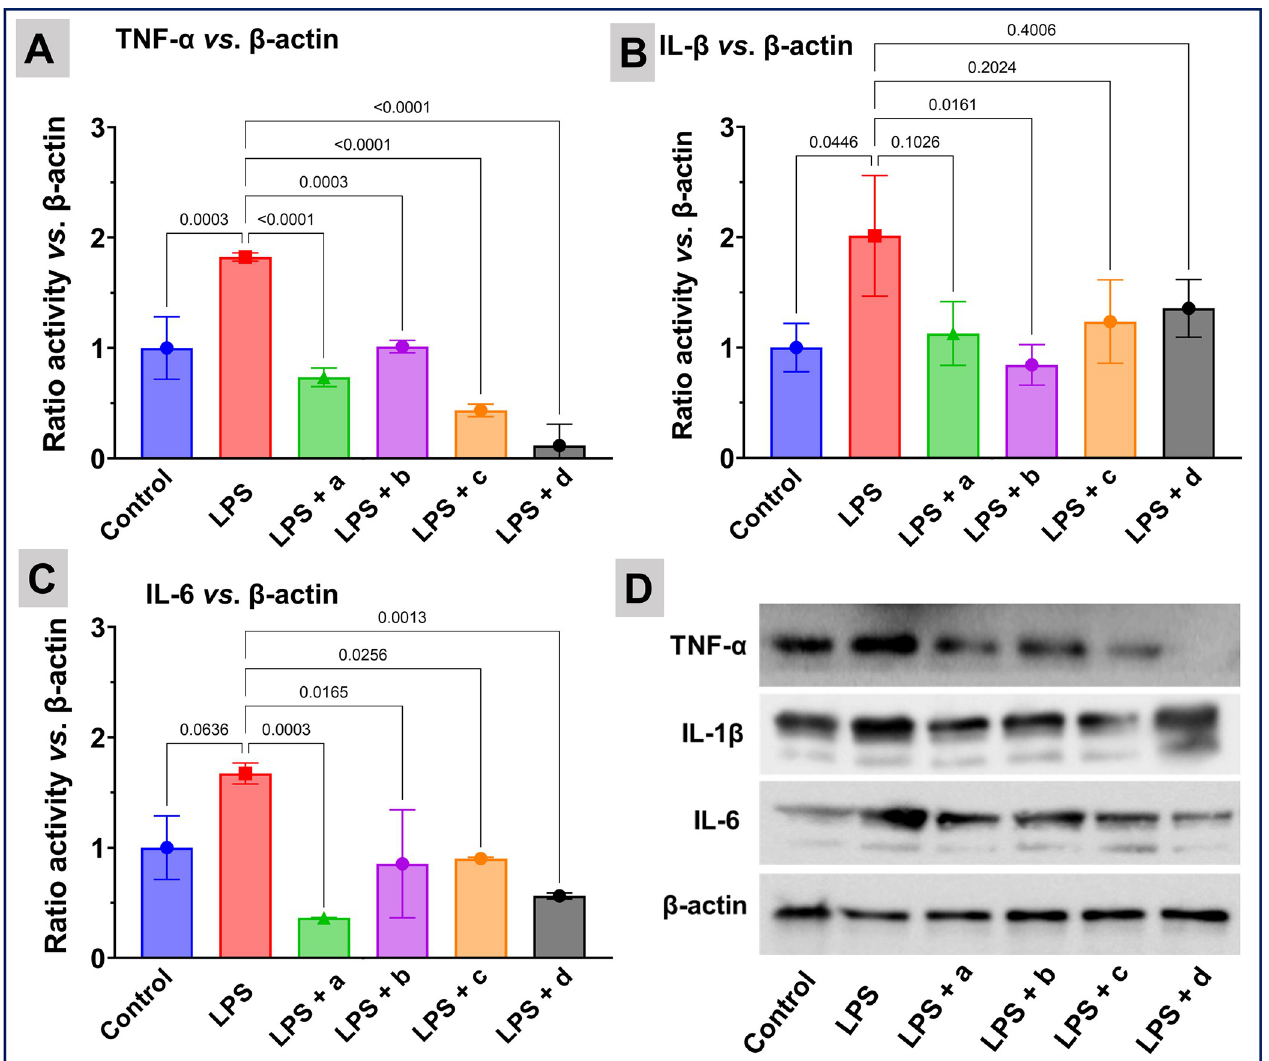
Fig 5. Impact of the nanoparticles on protein expression of TNF- α , IL-6, and IL-1 β . The experiments were carried out with mouse Raw 264.7 macrophages by Western blotting after co-treatment with LPS and Cur-Ag (Panel A), Cur-Ag INH (Panel B), Cur-Ag Tyr (Panel C), or Cur-Ag Qrc (Panel D) nanoparticles, respectively. β -actin acts as a standard. In Panels A, B, and C, the results are expressed as mean ± SD. The data shown is a compilation of three independent trials. P-values are shown above the square brackets; p < 0.05 was considered statistically